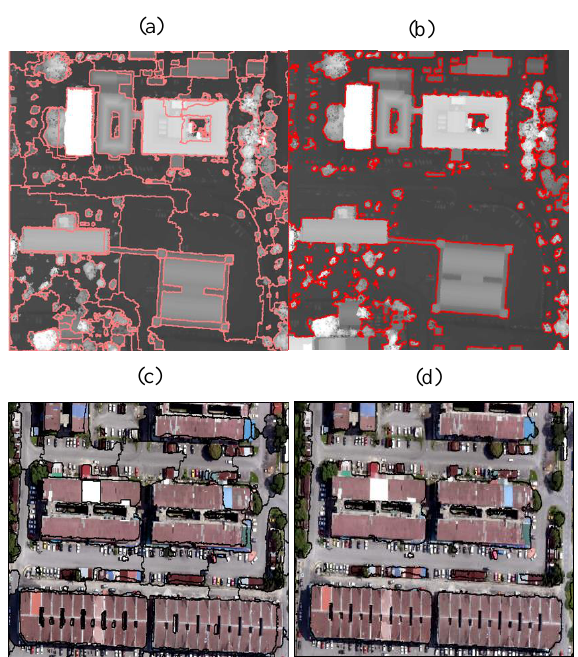
Figure 6 . The segmentation results (a), (c) before regularization and (b), (d) after regularization.